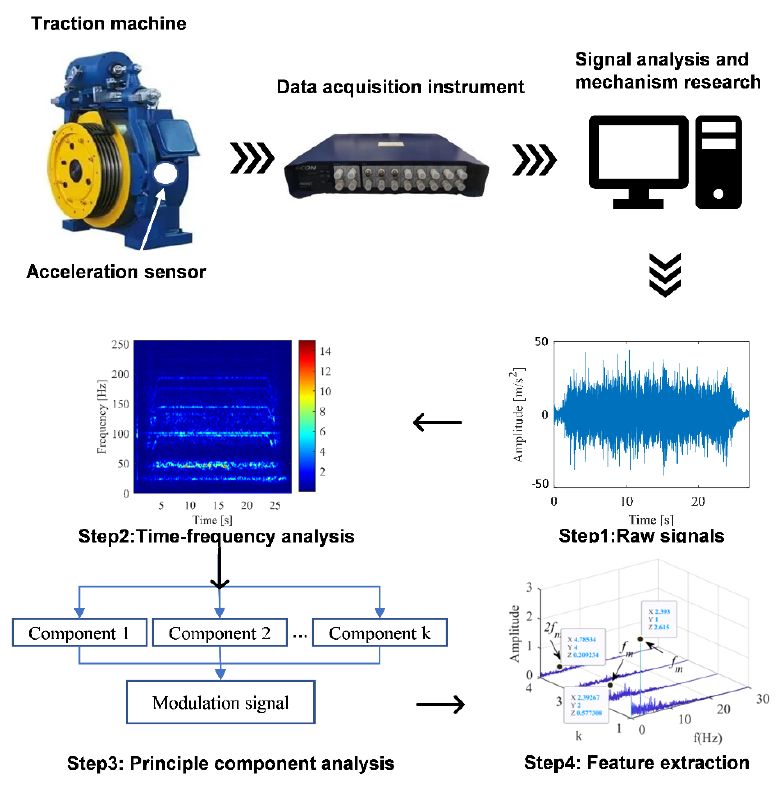
Figure 1. Flow chart of traction machine vibration signal acquisition and analysis.